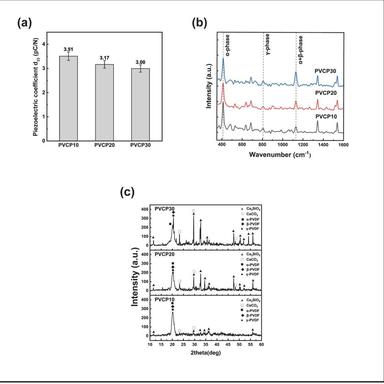
a) The piezoelectric coefficient (d33) of the CPS-PVDF scaffold after 7 d of hydration. Each error bar represents one standard deviation (n = 3). b) The Raman spectra and c) XRD patterns of 7-d hydrated CPS-PVDF scaffolds.